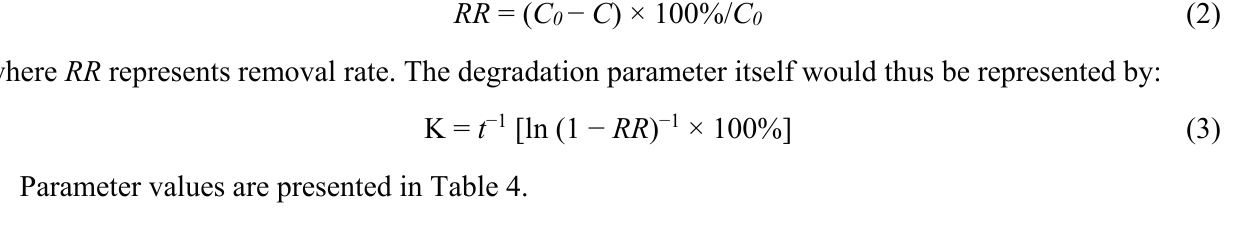
Table 4. Degradation parameters of the indexes in every unit.